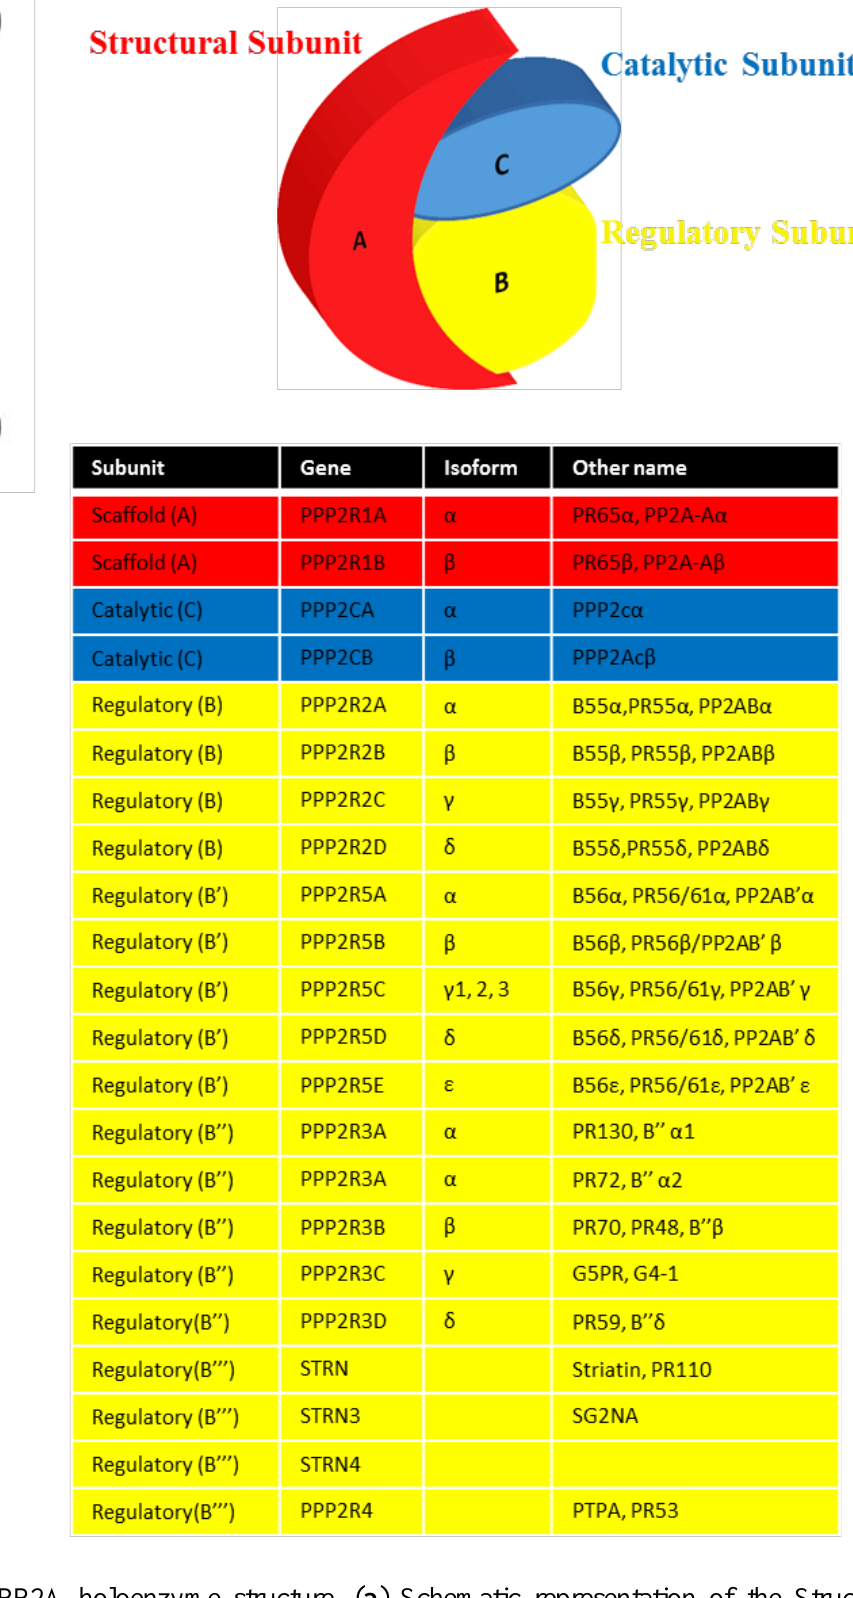
Figure 1. PP2A holoenzyme structure. ( a ) Schematic representation of the Structural (A), Regulatory (B) and Catalytic (C) subunits which form the PP2A holoenzyme. ( b ) Table showing the subunit, gene, isoform and alternative name for each